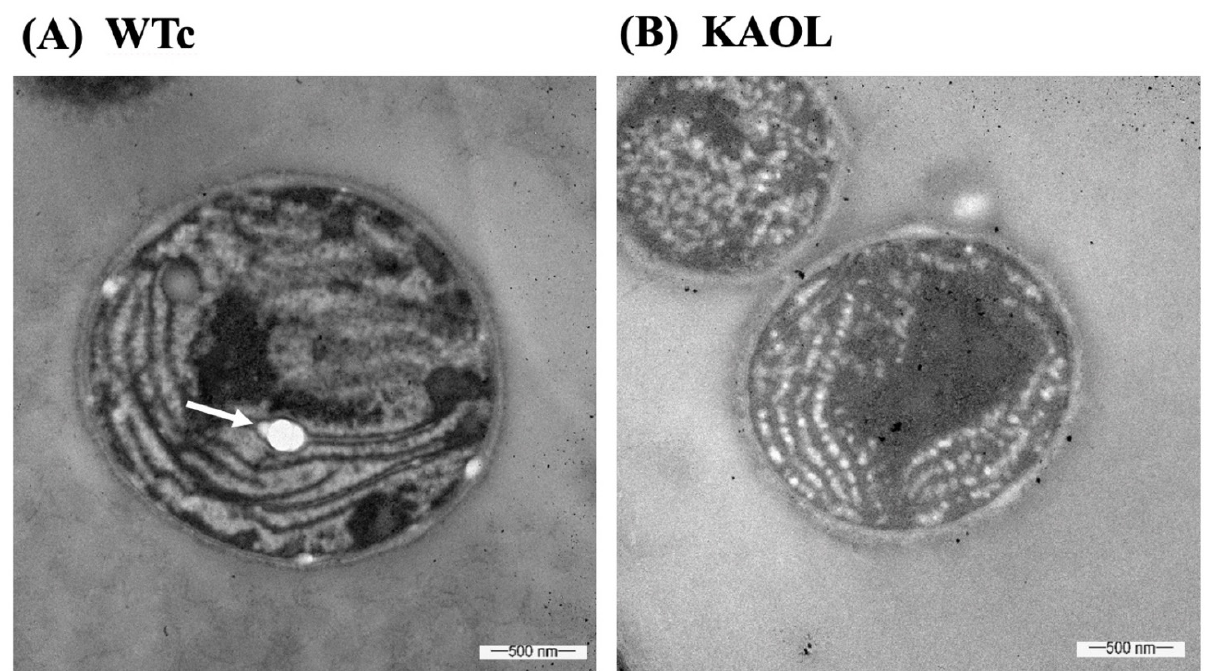
Figure 7. Transmission electron micrographs (TEMs) of Synechocystis WTc ( A ) and KAOL ( B ) strains under normal BG 11 medium for 5 days of cultivation. In ( A ), WTc images are shown in 40,000× magnifications. In ( B ), KAOL images are shown in 50,000× magnifications. In ( A ), the white dots (white arrow) represent the examples of electron-transparent bodies. In ( B ), abundant droplet-like white dots were located on regions of thylakoid membranes inside KAOL cells.